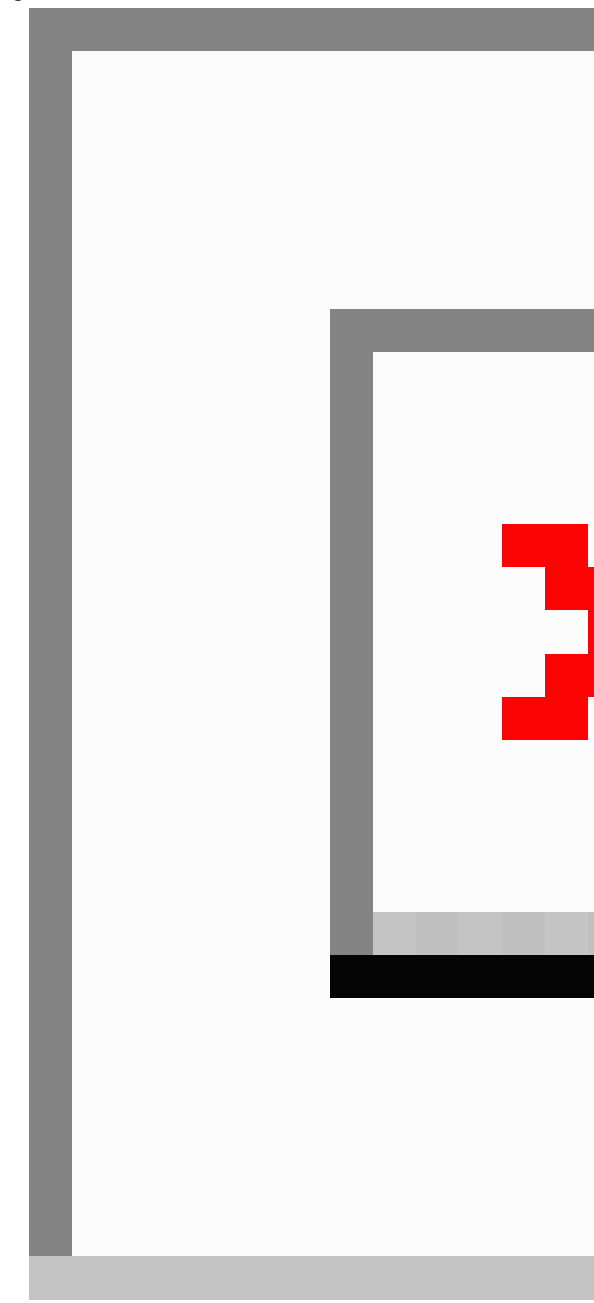
Figure 1. Flow chart of literature